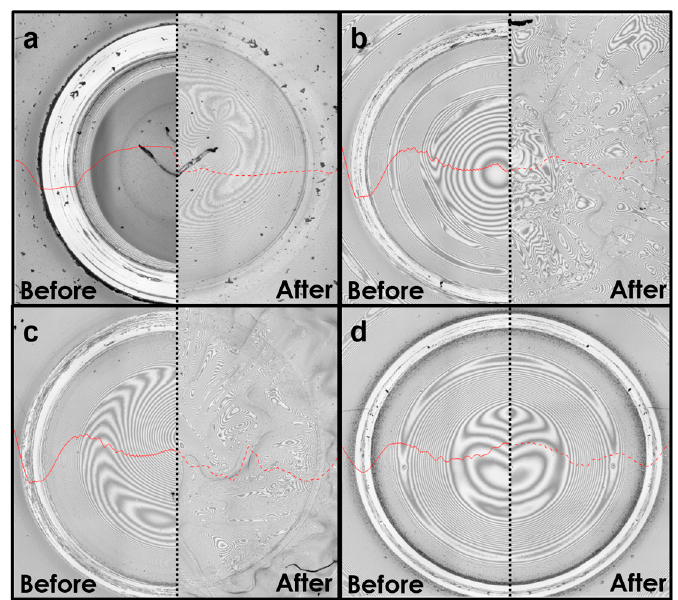
Figure 5. Three-dimensional scans of the surface morphology before/after the film was repaired: ( a ) left: before water treatment; right: after water treatment; ( b ) left: before methanol treatment; right: after methanol treatment; ( c ) left: before ethanol treatment; right: after ethanol treatment; ( d ) left: before acetone treatment; right: after acetone treatment. The solid red lines show the sectional curves before the repair, and the dashed red lines show the sectional curves after the repair.